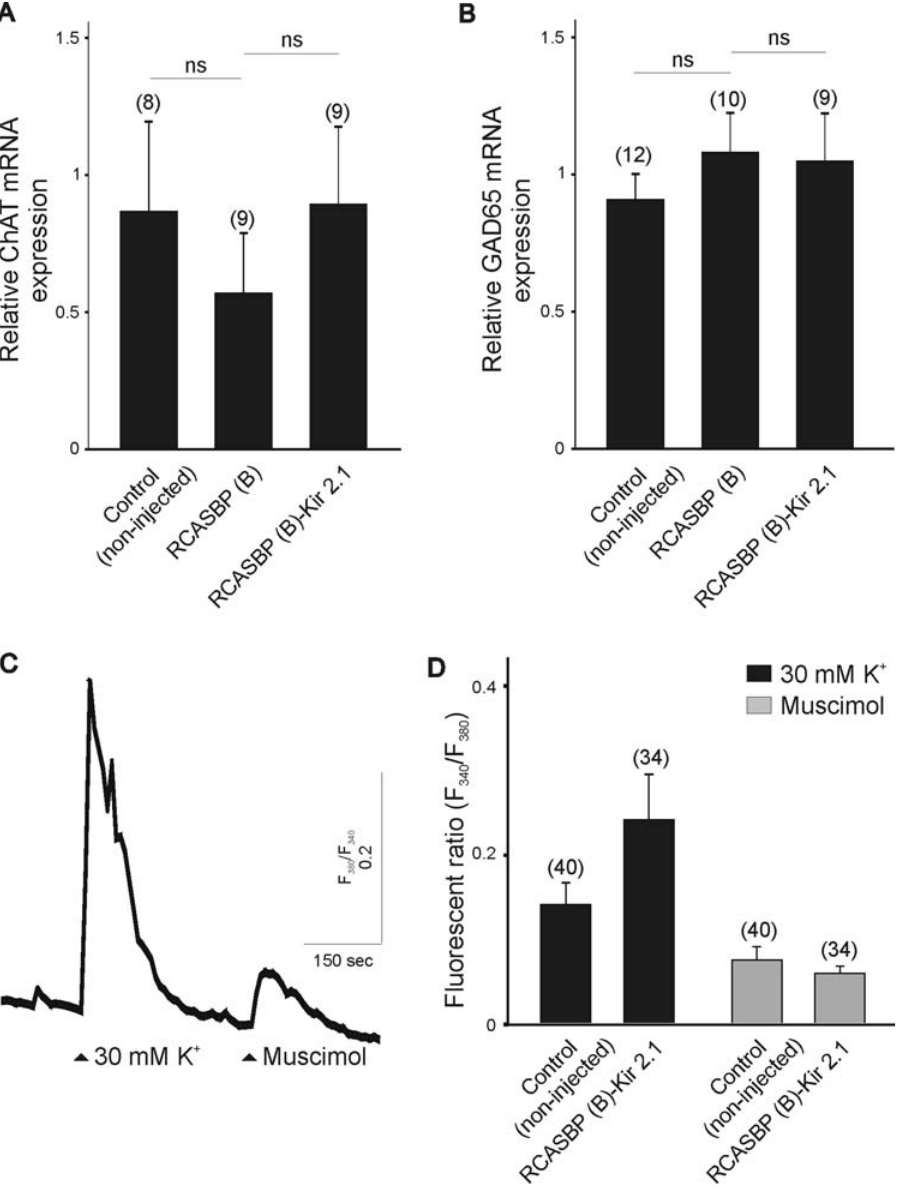
Figure 7. Effect of Kir2.1 expression on neurotransmitter specification and function in chicken spinal cord neurons. Inhibition of spinal cord activity does not alter the expression of the acetylcholine and GABA synthesizing enzyme ChAT (choline acetyltransferase, A ) and GAD (glutamate decarboxylase, B ) mRNA at E8. C) Stimulation of chicken spinal motoneurons with the GABA agonist causes a significant increase in intracellular Ca 2 + . D) There was no significant change in the muscimol evoked- Ca 2 + signals measured in control or RCASBP(B)-Kir2.1 infected embryos at E8. Acutely isolated motoneurons were incubated with the ratiometric Ca 2 + indicator Fura-2 for 30 min and stimulated with 100 m M muscimol for 30 sec. Stimulation with 30 mM K + served as a control.